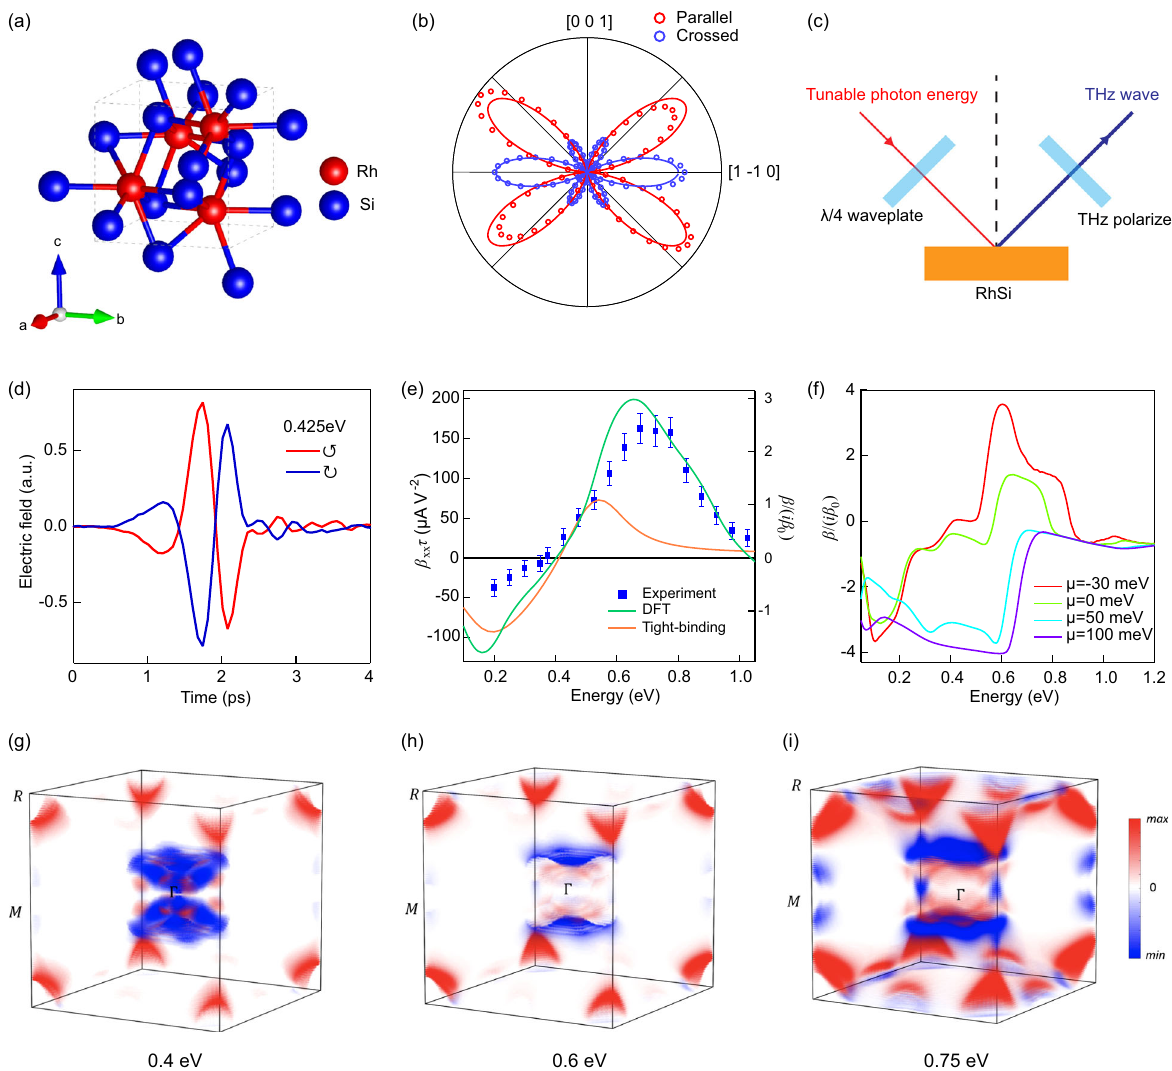
Fig. 6 CPGE measurement and calculation. a Crystal structure of RhSi. b Second-harmonic generation measured on the (110) surface of RhSi crystal at near-normal incidence. Solid red and blue lines are the best fi t of the experiment data. Open circles are data measured in the parallel- and crossed-polarizer geometry. c A schematic representation of the experimental geometry for the THz emission spectroscopy. d Detected emitted THz pulses in the incident plane from RhSi at the 45-degree incidence of left-handed and right-handed circularly polarized light at the photon energy of 0.425 eV. e Experimental CPGE spectrum of RhSi (blue squares) compared to fi rst-principles at μ = − 30 meV and T = 300 K and tight-binding calculations. Both calculations use a broadening η = 100 meV. f First-principles calculation of the trace of the CPGE components in units of the quantization constant β 0 = π e 3 / h 2 with spin – orbit coupling at different chemical potential μ from the zero energy de fi ned in Fig. 3a, b at T = 0 K, and a broadening parameter η = 10 meV. While μ = 0 and − 30 meV sit below the Γ threefold node (see Fig. 3a, b), the two remaining chemical potentials lie above the Γ node. g – i Momentum-resolved contribution of the CPGE photocurrent at 0.4, 0.6, and 0.75 eV for the green curve in e . The contribution is shown by the red – blue color scale, with red being positive and blue being